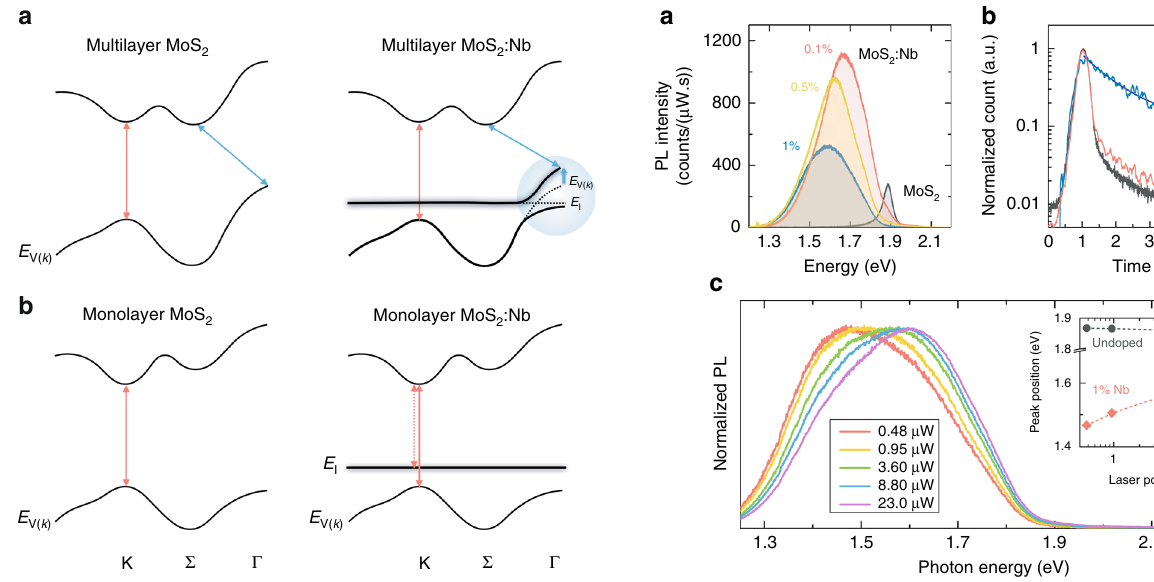
Fig. 4 Photoluminescence in monolayer Nb-doped MoS 2 . a Room temperature photoluminescence (PL) characteristics of monolayer MoS 2 and MoS 2 :Nb. The spectra were collected under excitation with a 4.2 μ W Ar-ion laser line (488 nm). b Time-resolved PL of monolayer MoS 2 and MoS 2 :Nb. Black curve represents the instrumental response function (IRF). c A series of PL spectra with different excitation laser power for 1% Nb- doped MoS 2 monolayer. Inset shows the gradual PL peak shift of MoS 2 :Nb upon increasing laser input power in comparison with undoped MoS 2